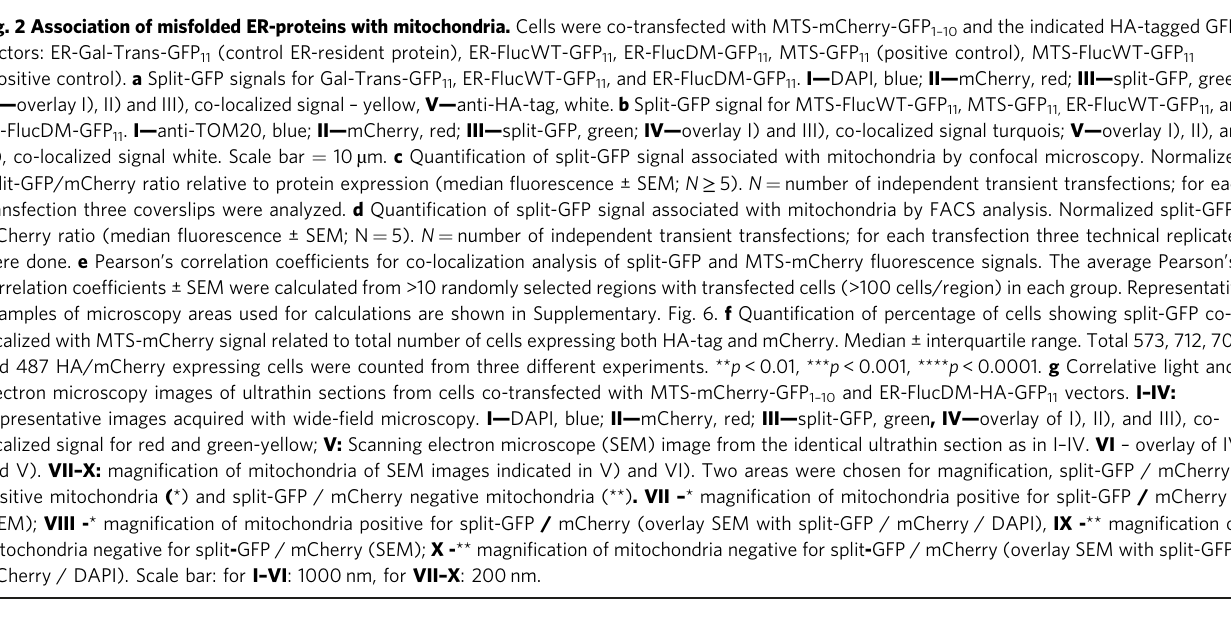
Fig. 2 Association of misfolded ER-proteins with mitochondria. Cells were co-transfected with MTS-mCherry-GFP 1 – 10 and the indicated HA-tagged GFP 11 vectors: ER-Gal-Trans-GFP 11 (control ER-resident protein), ER-FlucWT-GFP 11 , ER-FlucDM-GFP 11 , MTS-GFP 11 (positive control), MTS-FlucWT-GFP 11 (positive control). a Split-GFP signals for Gal-Trans-GFP 11 , ER-FlucWT-GFP 11 , and ER-FlucDM-GFP 11 . I — DAPI, blue; II — mCherry, red; III — split-GFP,